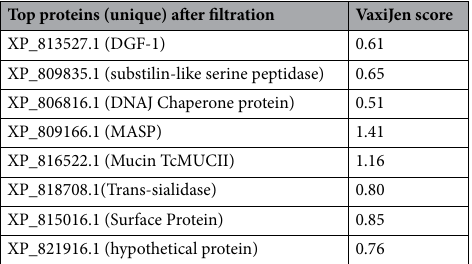
Top proteins (unique) after